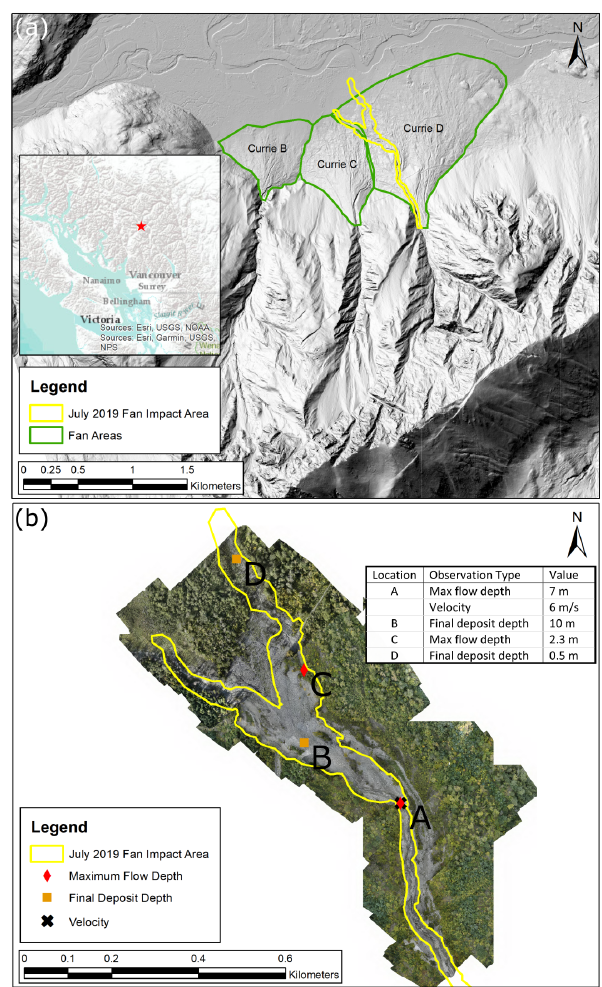
Figure 11. Currie D 2019 impacts. Hillshade derived from pre- event (2017) lidar data provided by the Squamish-Lillooet Regional District (a) and post-event orthophoto obtained from the 2019 UAV survey (b)